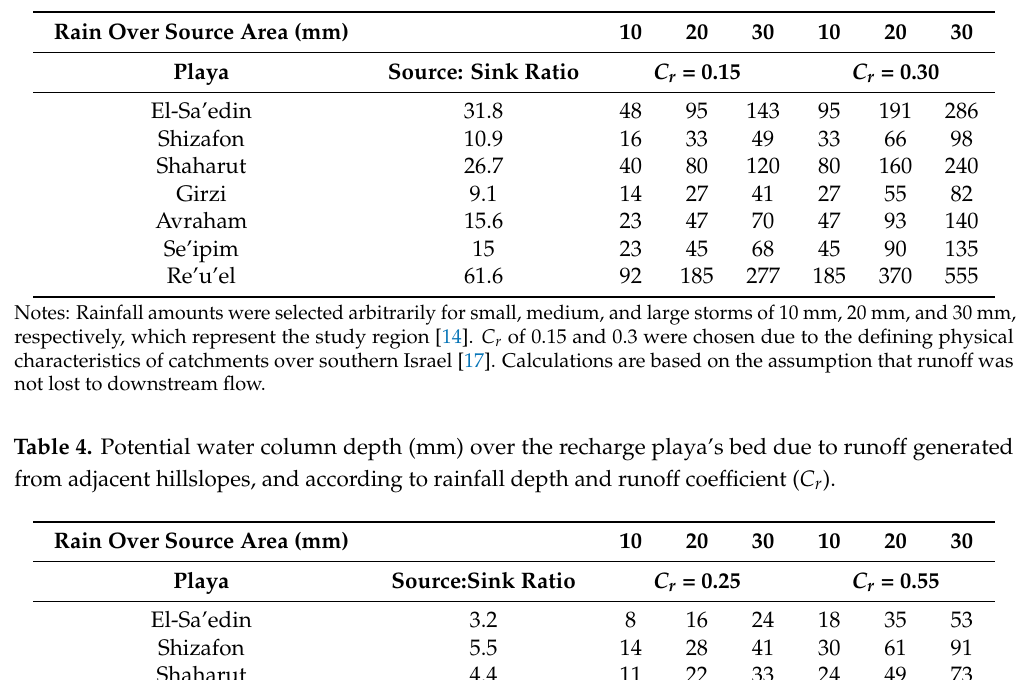
Table 3. Potential water column depth (mm) over the recharge playa’s bed due to runoff generated from the catchment, excluding the playa’s adjacent hillslopes, and according to rainfall depth and runoff coefficient ( C r ).